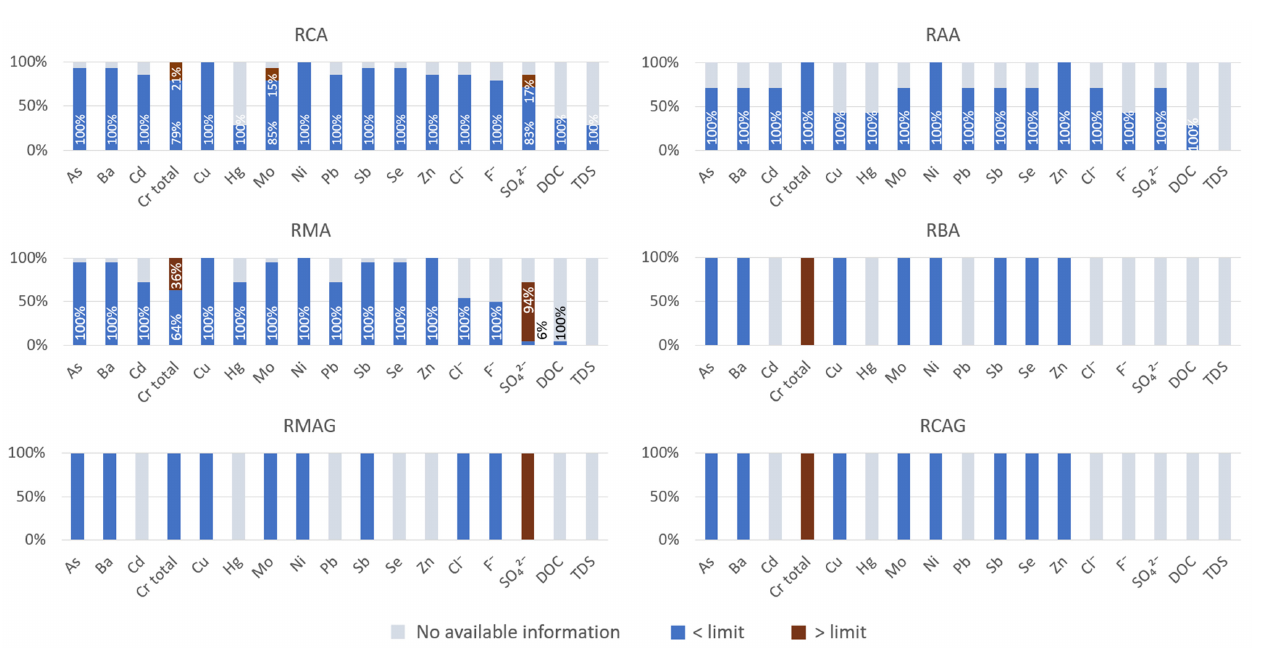
Figure A1. Percentage of RA whose eluate complies or not with the content limits under European Union legislation [41] for each analyte by type of RA (the percentage in each column considers only available information)